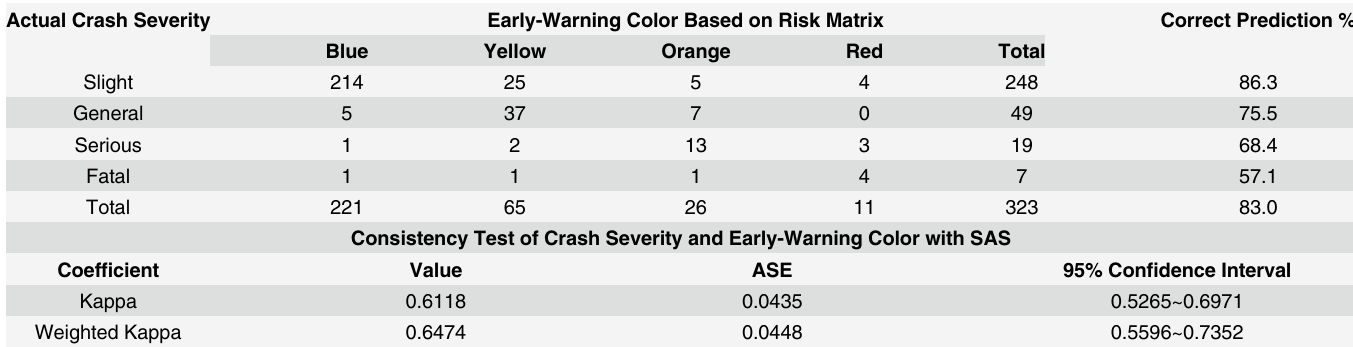
Table 6. Comparisons of early-warning color and actual crash severity.